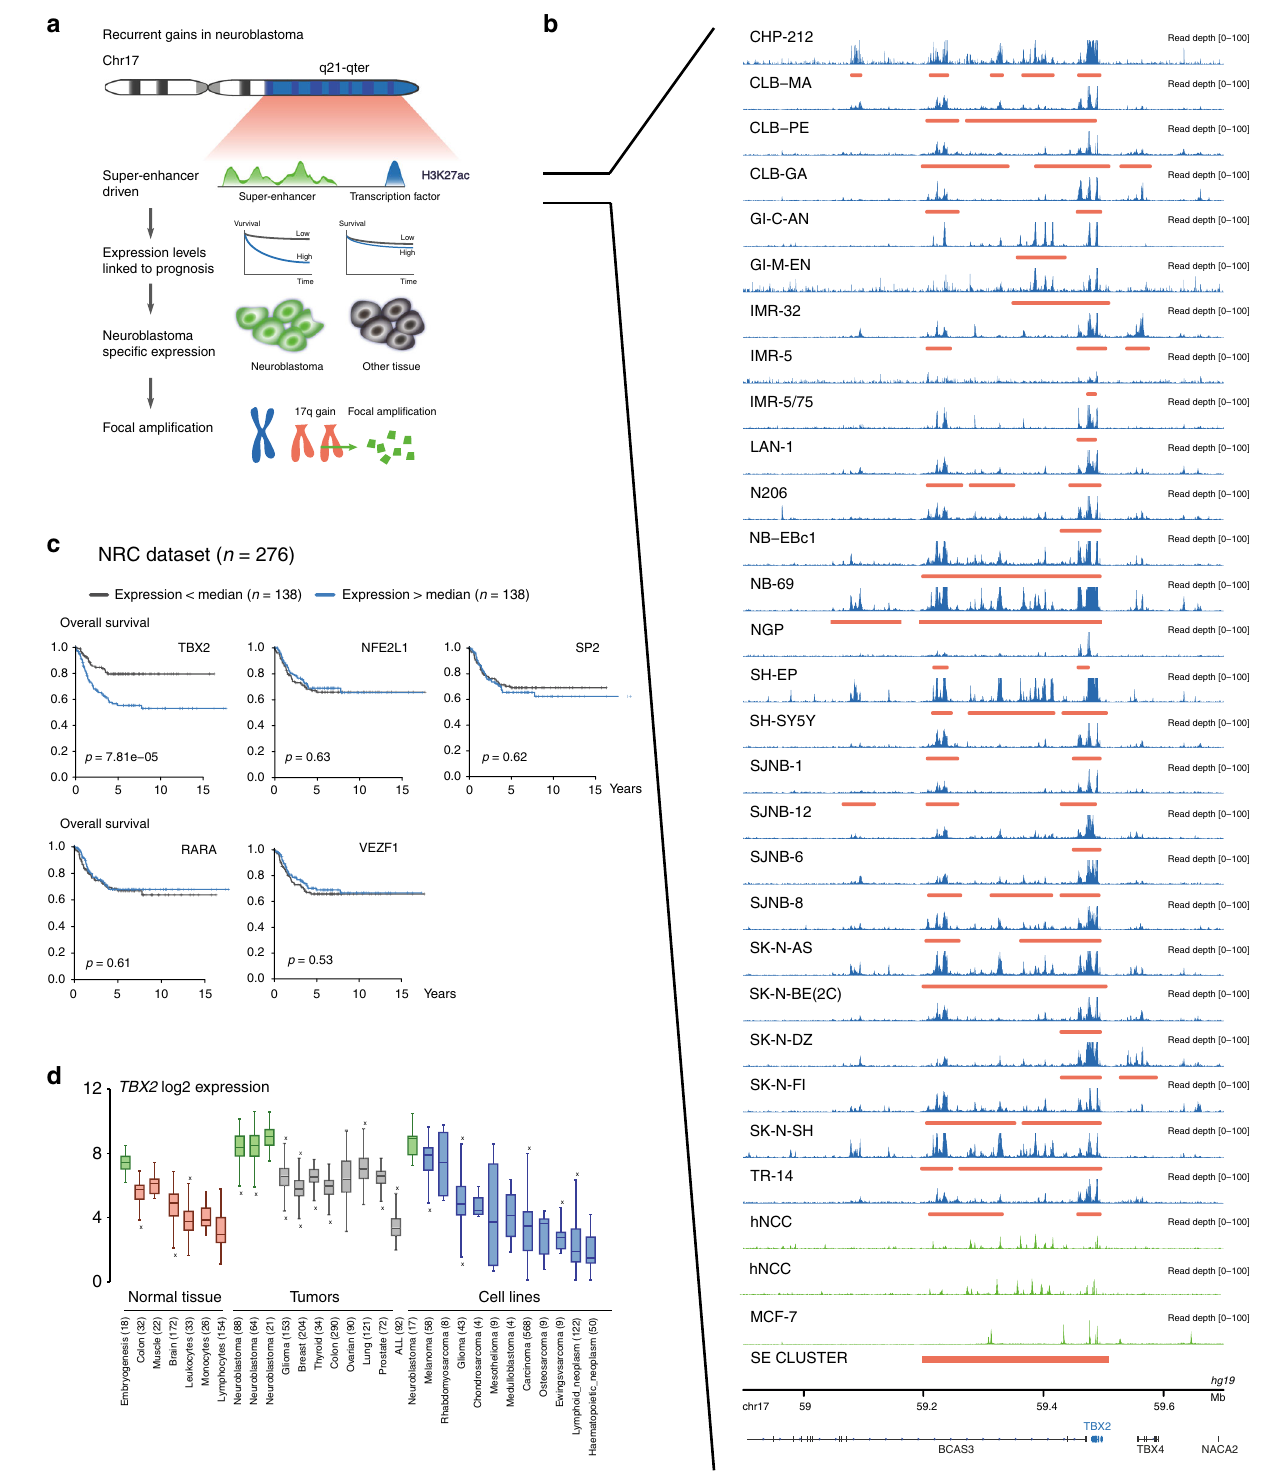
Fig. 1 TBX2 is a super-enhancer marked 17q transcription factor in NB. a Prioritization strategy to fi nd SE-driven candidate oncogenes on chr17q. b H3K27ac activity in a region upstream of TBX2 in 26 NB cell lines (blue), non-malignant neural crest cell lines (green) and the non-embryonal breast cancer cell line MCF-7 (green). The Lilly annotated SE regions are indicated in red. The cluster (out of 276 clusters on chr17q) containing the overlapping SE used in the prioritization process is annotated at the bottom. c Kaplan – Meier analysis (overall survival) of 276 neuroblastoma patients (NRC NB tumor cohort, GSE85047) with high or low expression (using median as cut-off) of the fi ve prioritized candidate oncogenes ( TBX2, NFE2L1, SP2, RARA, and VEZF1 ). d TBX2 is highly expressed during embryogenesis as compared to normal adult tissue. TBX2 is highly expressed in NB tumors and NB cell lines as compared to tumors or cell lines from other entities. Boxplots are drawn as a box, containing the 1st quartile up to the 3rd quartile of the data values. The median is represented as a line within the box. Whiskers represent the values of the outer two quartiles maximized at 1.5 times the size of the box. If one or more values outside of the whiskers are present, then this is indicated with a single mark ‘ x ’ next to the implicated whisker NATURE COMMUNICATIONS| (2018) 9:4866 |DOI: